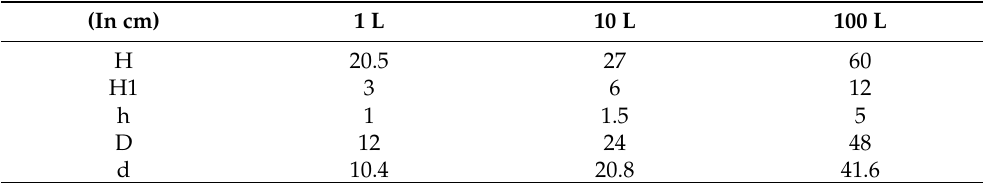
Figure 1. Schematic representation of the experimental set-up. Table 1. Overview of the measurements of the experimental set-up of all three reactor sizes, repre- sented in Figure 1.